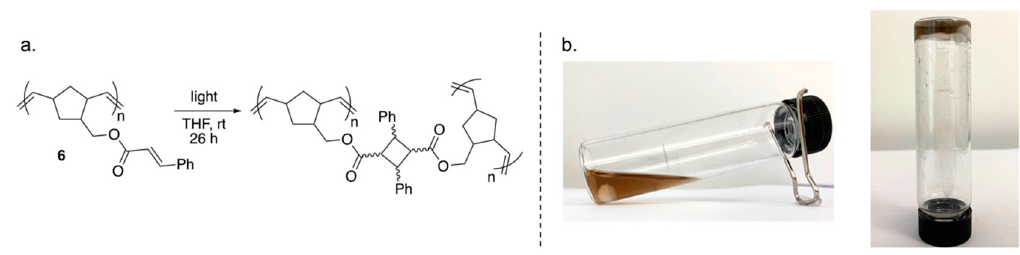
Figure 2. ( a ) Cross-linking of 6 through [2 + 2] cycloaddition. ( b ) Photograph of THF solution of 6 before exposure to sunlight (left) and photograph after exposure to sunlight and decantation of excess solvent (right).